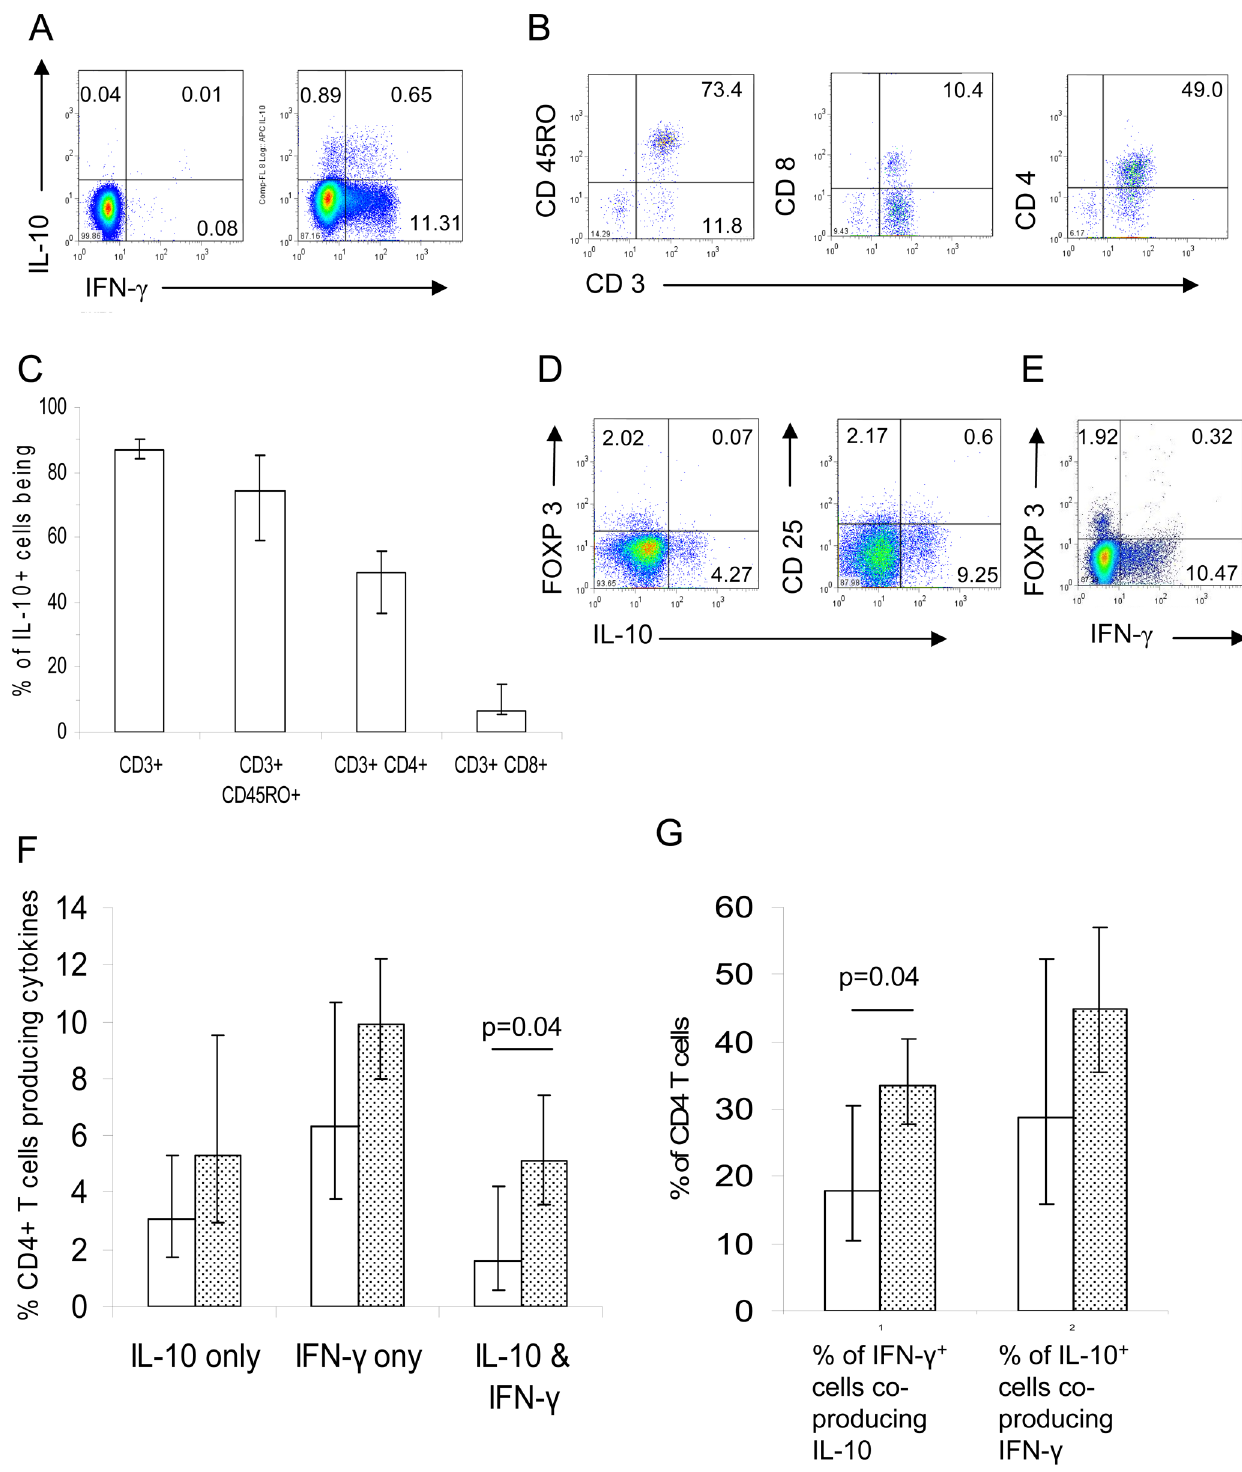
Figure 6. Phenotypic characterization of cytokine-producing cells. PBMC from 30 children with acute P. falciparum infection were cultured with growth medium (GM) or pulsed with PMA and Ionomycin (P/I) for 5 hours and assessed for the production of IL-10 and IFN- c by flowcytometry. (A) representative example of PBMC stained with isotype control (left panel) or anti- IL-10 and anti-IFN- c (right panel). (B) Representative example of the phenotype of IL-10 producing cells. (C) Proportion of IL-10 producing cells. The geometric mean with CI95% is shown. (D) Representative example of co-staining for IL-10 and FOXP3 (left panel) or CD25 (right panel). Across all samples tested, 0.13% (median; CI 95%: 0.09–0.16%) of PBMC stained positively for both IL-10 and FOXP3, corresponding to 2.4% (median; CI95%: 1.7–4%) of IL-10 producing cells being FOXP3 + . Approx 0.79% (median; CI95%: 0.69–1.1%) of CD3 + CD4 + PBMC were IL-10 + and CD25 + , corresponding to a 8.68% (median; CI 95%: 4.9–9.8%) of IL-10 + T cells being CD25 + . (E) Representative example of co-staining for IFN- c and FOXP3. Across all samples tested, 0.29% (median; CI 95%: 0.21–0.37%) of PBMC stained positively for both IFN- c and FOXP3, corresponding to 0.97% (median; CI95%: 0.67–1.27%) of IFN- c producing cells being FOXP3 + . (F) Percentage of IL-10 single